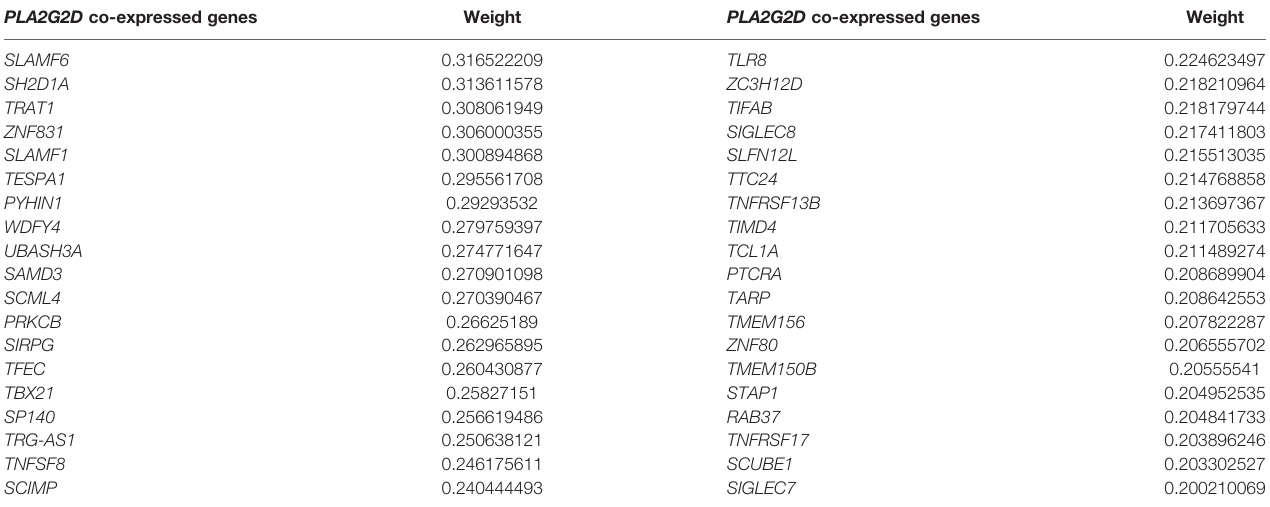
TABLE 2 | List of genes co-expressed with PLA2G2D with weight value >0.20. PLA2G2D co-expressed genes Weight PLA2G2D co-expressed genes Weight